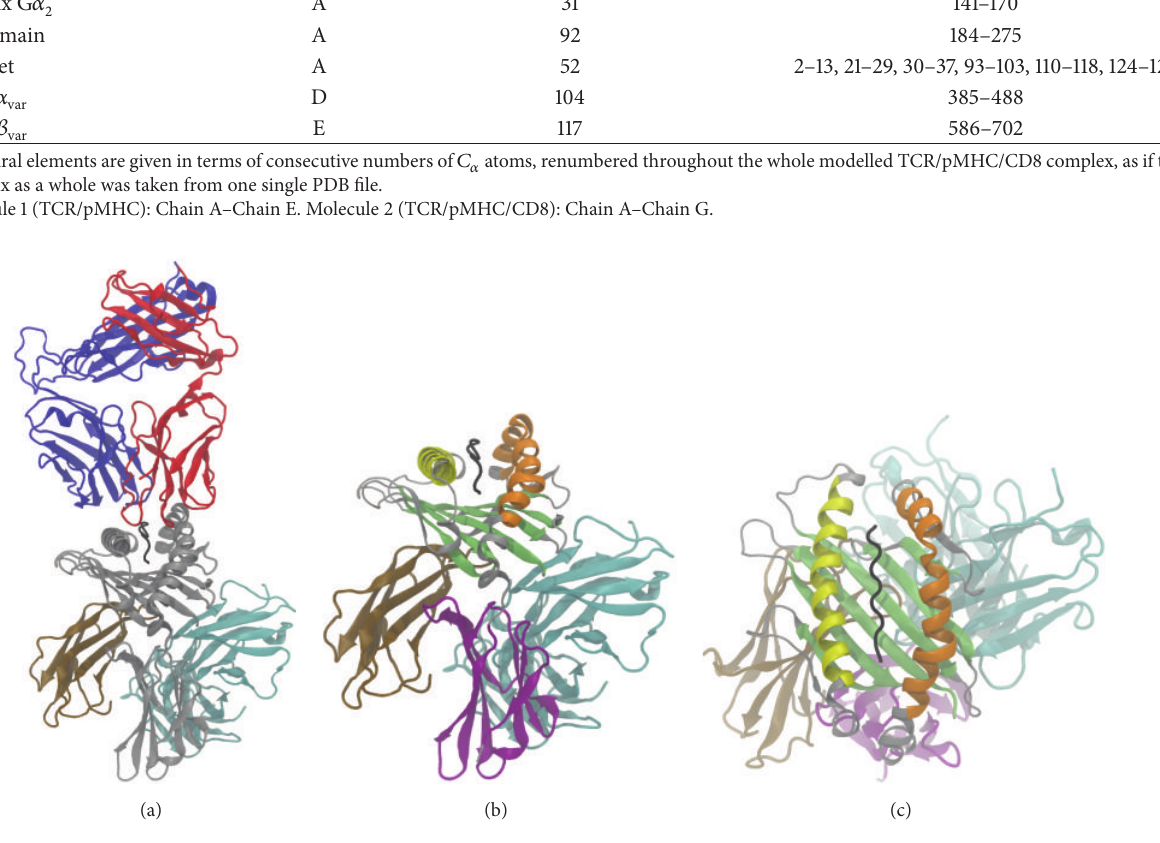
Figure 1: Structure description. (a) Cartoon representation of the TCR/pMHC/CD8 system: MHC (grey), 𝛽 2 -microglobulin (ochre), peptide (black), TCR 𝛼 -chain (red), TCR 𝛽 -chain (blue), and CD8 𝛼 1 and CD8 𝛼 2 (cyan). (b, c) Cartoon representation of the pMHC/CD8 complex: 𝛼 -helix G 𝛼 𝛼 𝛽 -sheet (lime), and CD8 𝛼 𝛼 𝛼 -helix G 𝛼 1 (yellow), 2 (orange), 3 -domain (purple), 1 and CD8 2